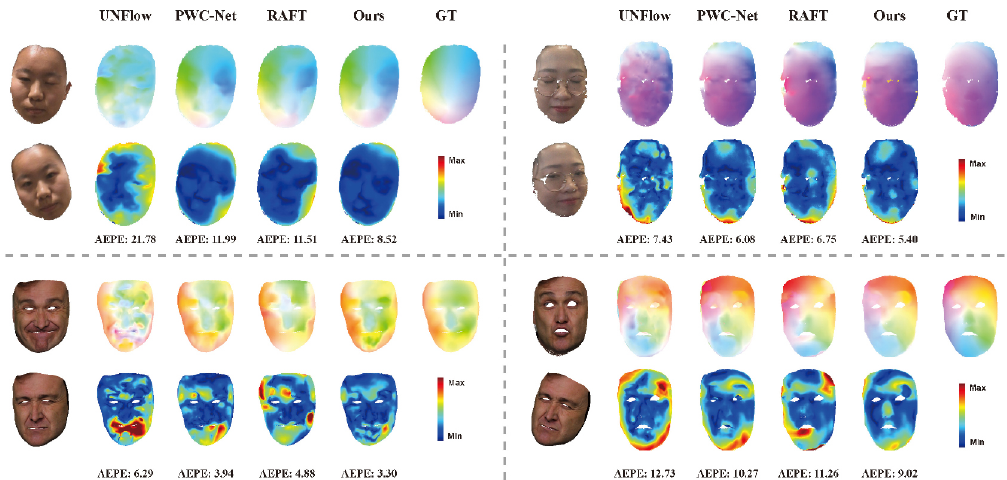
Fig. 6 Top to bottom: qualitative comparisons on unoccluded regions using the FaceFlowData and Synthetic Face datasets, respectively, with two frame pairs for each dataset. For each method, we show the better result of the two versions; for each sample, we compute optical flow from the upper frame to the lower frame. For each sample, the first row shows the predicted optical flow for the methods and the ground-truth, and the second row visualizes the errors (red indicates higher error, blue lower) for the methods.